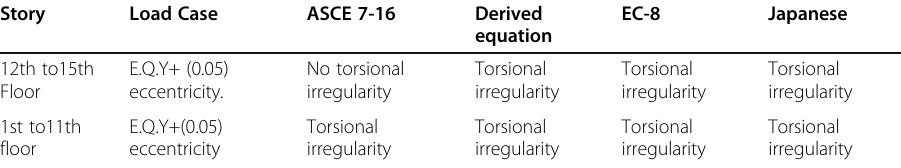
Table 12 Torsional irregularity check of 3rd model due to ASCE 7-16, EC-8, Japanese, and derived equation